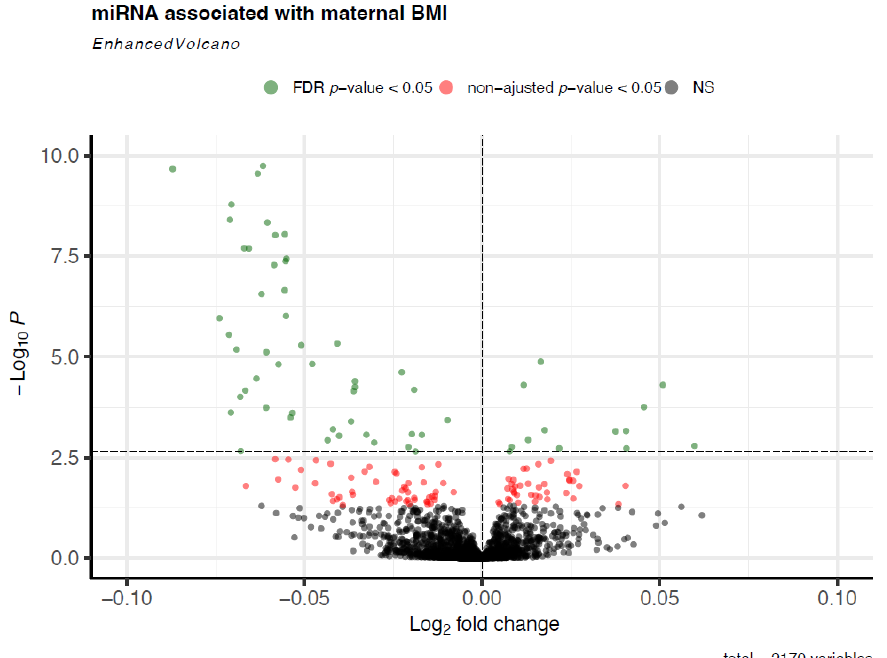
Figure 1. Plasmatic miRNAs associated with maternal BMI at 1st trimester of pregnancy. This volcano plot shows the miRNAs associated with maternal BMI. Each point represents a single miRNA. The vertical dotted line represents a log2 fold change of 0, and the horizontal dotted line represents the FDR-adjusted q-value threshold of < 0.05. The model was adjusted for sequencing lane and run, maternal and gestational age at 1st trimester, and parity. The fold change represents the change in miRNA abundance for an increase of one unit of maternal BMI in 1st trimester of pregnancy. Abbreviations: FDR: false discovery rate; NS: not significant.